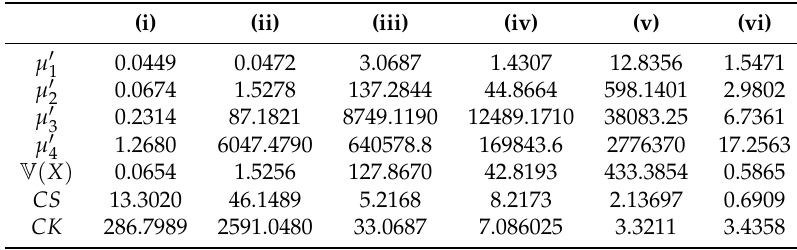
Table 1. Some moments, variance, skewness and kurtosis of the OGWG ( c , α , p , β ) distribution for the following selected parameters values in order ( c , α , p , β ) ; (i): ( 0.3,0.2,0.2,1 ) , (ii): ( 0.1,0.1,0.2,1 ) ,